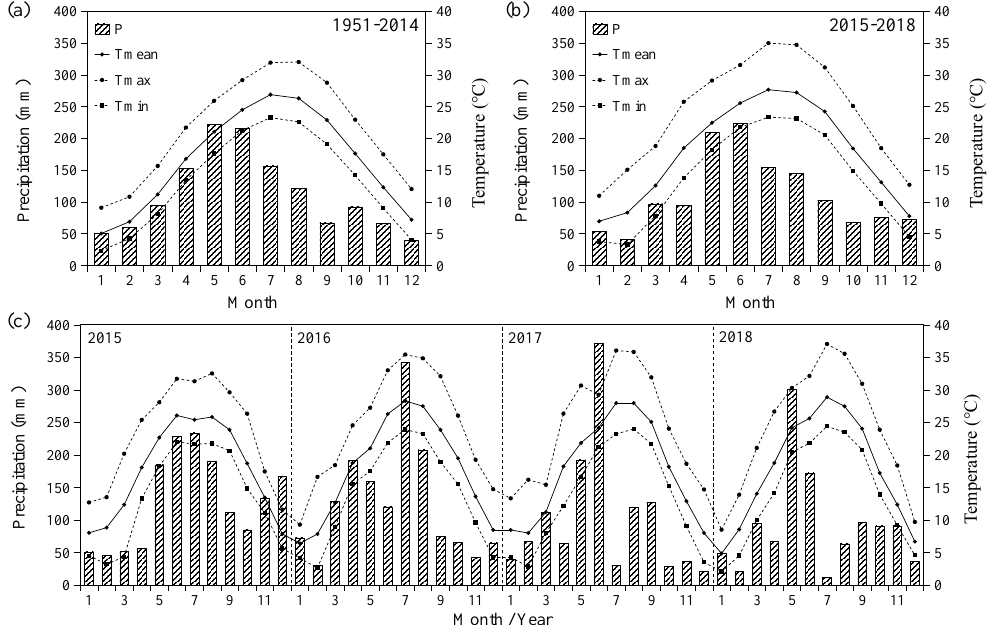
Figure 1. Monthly precipitation (P), monthly mean (Tmean), average of maximum (Tmax), and minimum (Tmin) temperatures (°C) of Huitong from 1951 to 2014 ( a ), from 2015 to 2018 ( b ), and from January 2015 to December 2018 ( c ), recorded at our ecological research station in Huitong, Hunan province.